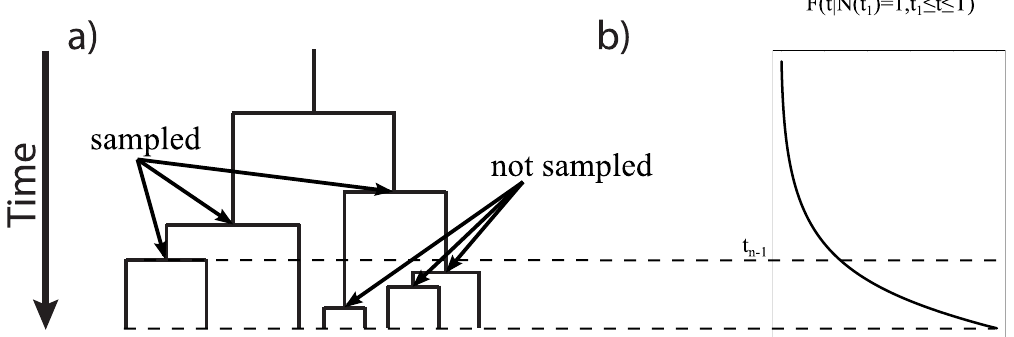
Figure 2. Illustration of diversified sampling and the probability density. a) A reconstructed tree where three speciation events are sampled and last three speciation events are not. b) The cumulative probability density of the time of a speciation event. All non-sampled speciation events occurred some time after the dashed line ( t n { 1 ) and thus have the probability 1 { F ( t n { 1 ) .